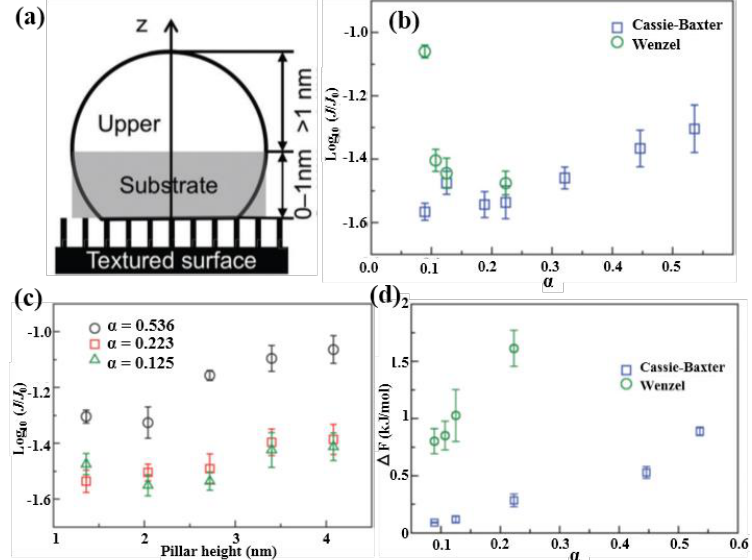
Figure 16. ( a ) Schematic illustration of the substrate (shaded part) and the upper region, which are 0.0–1.0 nm and greater than 1.0 nm above the surface, respectively; ( b ) The ice nucleation rate as a function of surface fraction at 203 K, for different nanostructured surfaces with pillar height, h = 0.136 nm; ( c ) The ice nucleation rate as a function of pillar height at 203 K, for the Cassie–Baxter state with different surface fractions; ( d ) Variation of the surface free energy difference with respect to α for nanostructured surfaces with different wetting states. (Adapted from [156] with permission; Copyright 2016 RSC).